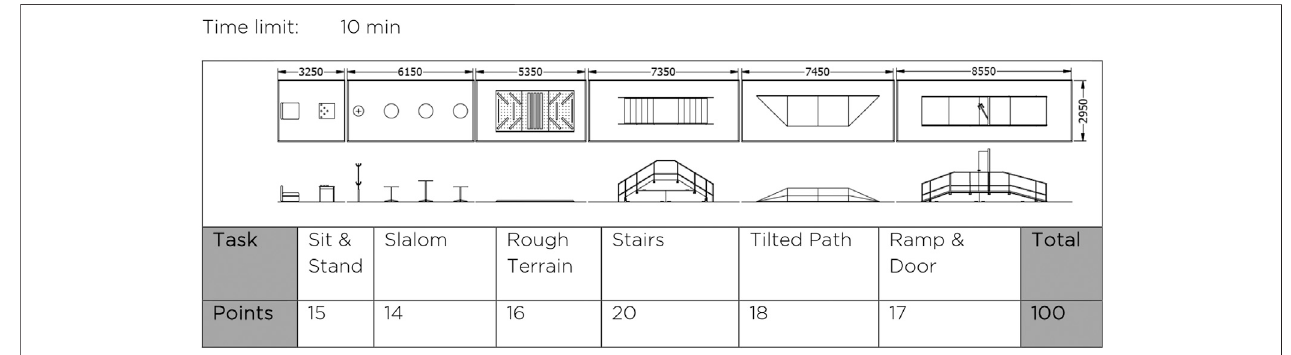
FIGURE 1 | EXO race track from Cybathlon ’ s